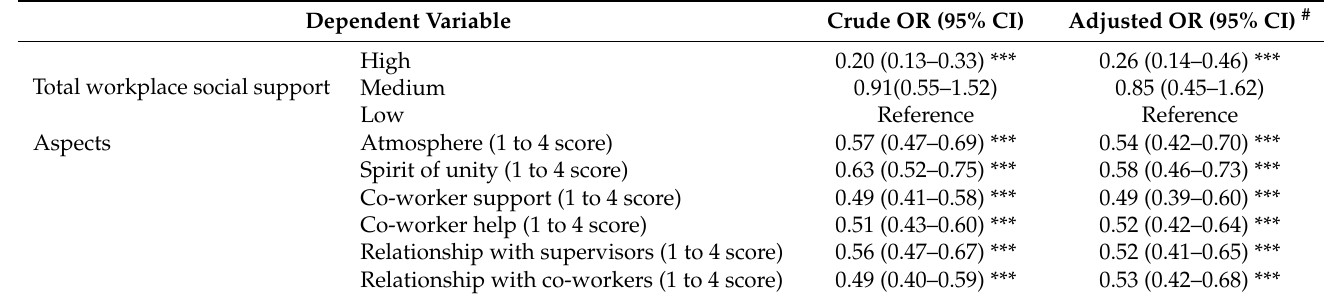
Table 3. Associations between social support in the workplace and migraine